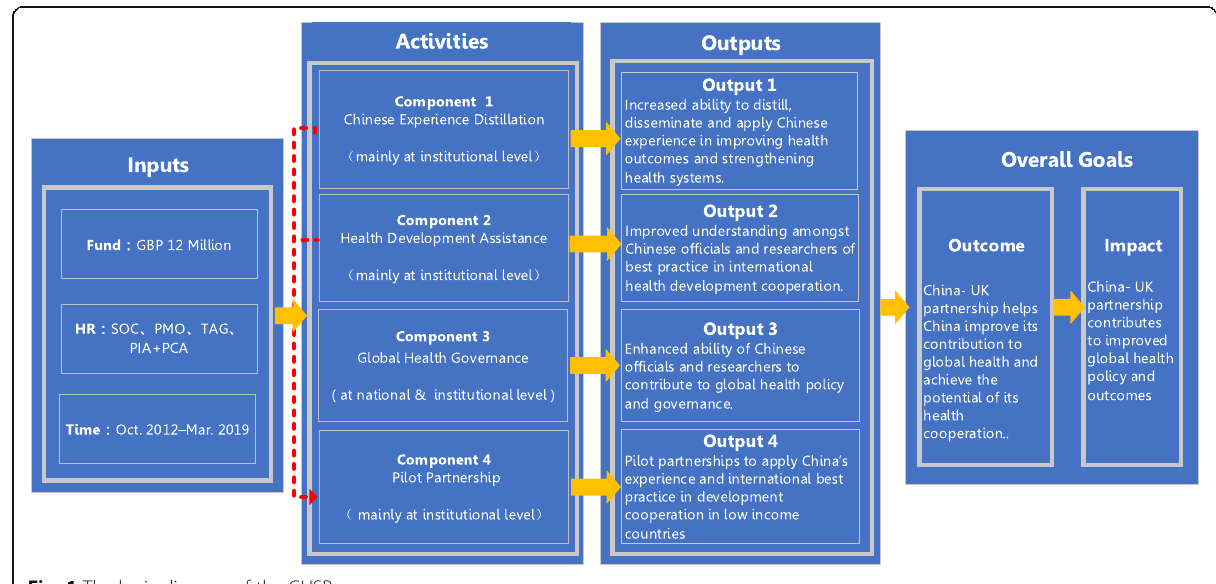
Fig. 1 The logic diagram of the